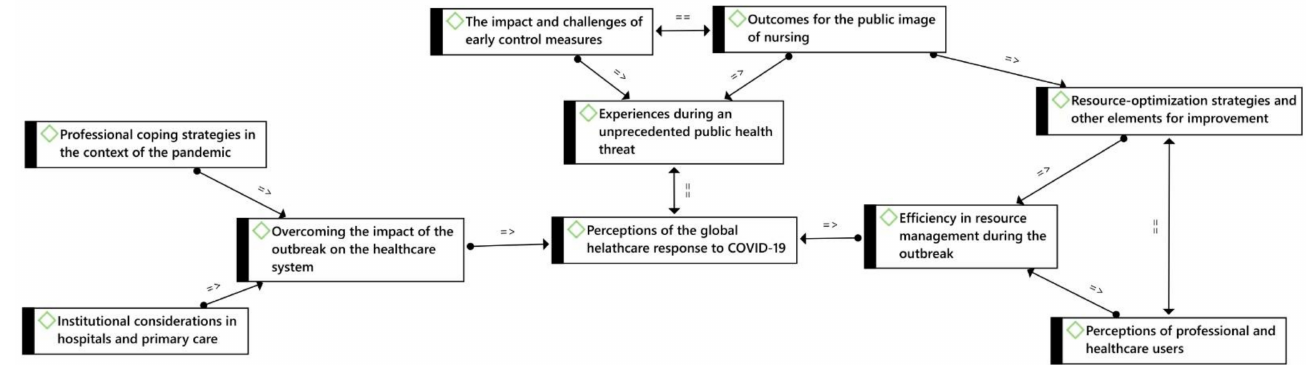
Figure 1. Conceptual map based on experiences and perceptions of the global healthcare response to COVID-19. = =: associated with; =>: cause of.